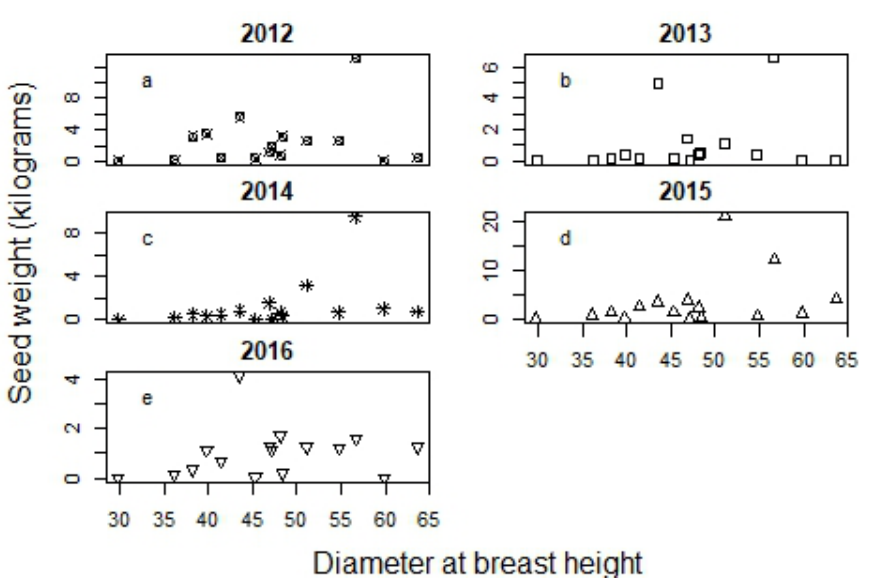
Figure 3. Annual seed production (grams) by Carapa guianensis diameter at breast height in Amapá, Brazil in ( a ) 2012; ( b ) 2013; ( c ) 2014; ( d ) 2015; and ( e ) 2016.